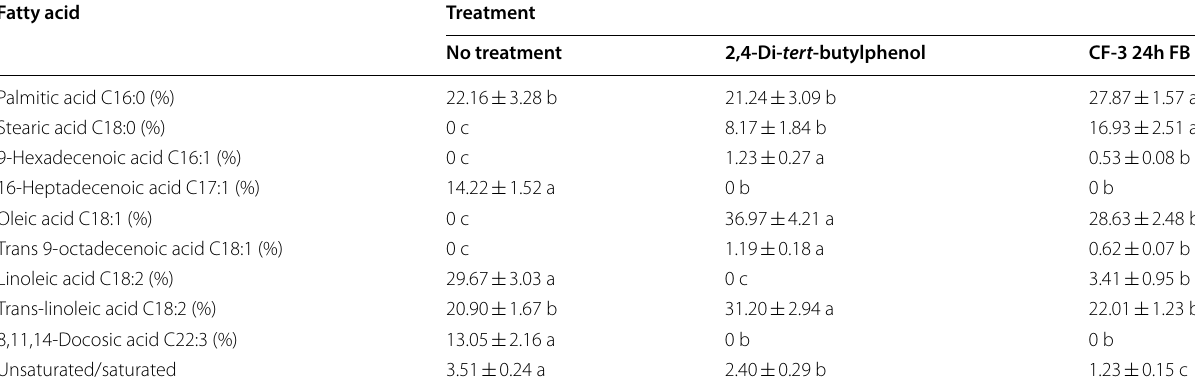
The mean and standard error in the table were taken from three replicates, and the different letters indicated that the different treatments of the same strain had significant differences ( P < 0.05 )